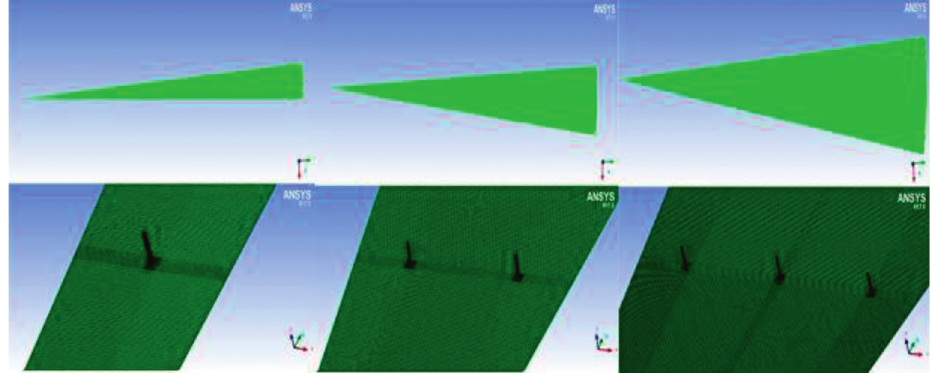
Figure 3: 3 ways to divide the air film of annular array microporous throttling aerostatic bearing. Table 2: Bearing calculation parameters.